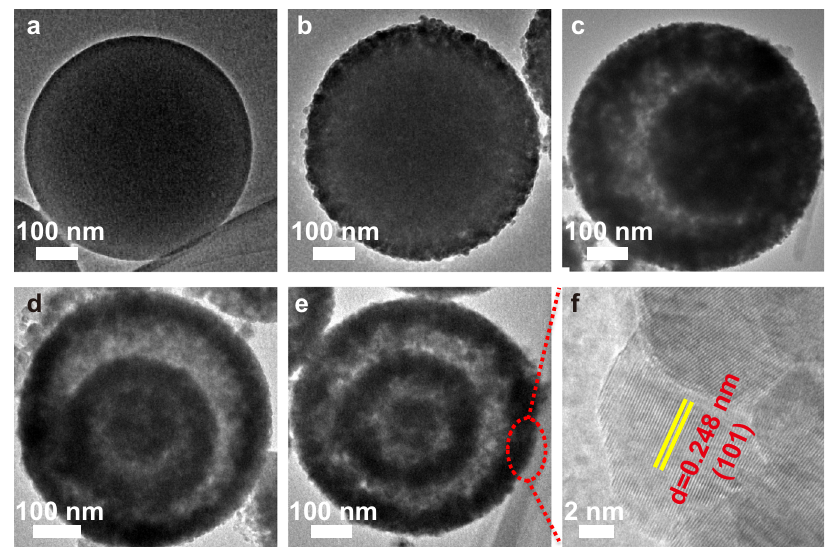
Fig. 3 TEM images of Mn, Zn-CPSs. a Before calcination and after calcination for b 0.5 h, c 1 h, d 2 h, and e 3 h. f Depicts the HRTEM of Mn, C-codoped ZnO with lattice fringes of 0.248nm corresponds to the (101) plane of Wurtzite